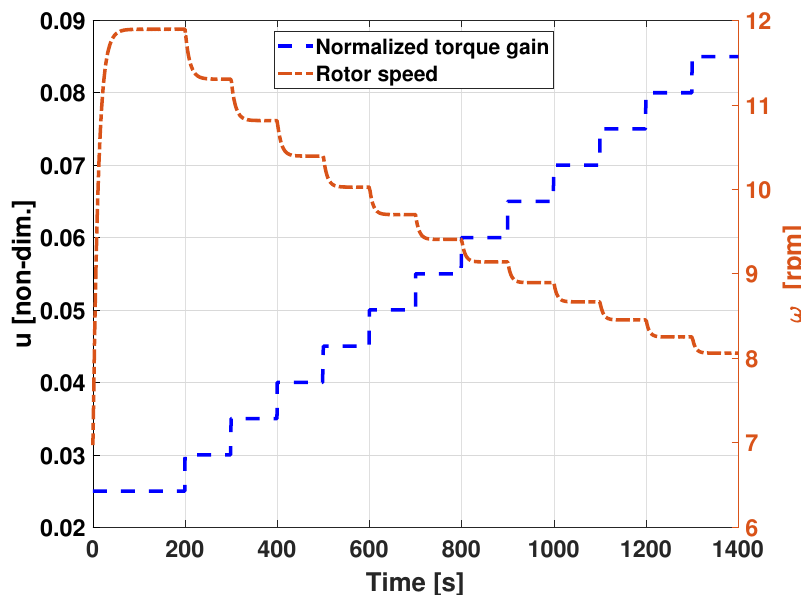
Figure 4. Rotor speed dynamics for step changes in u ( V = 8 m/s).